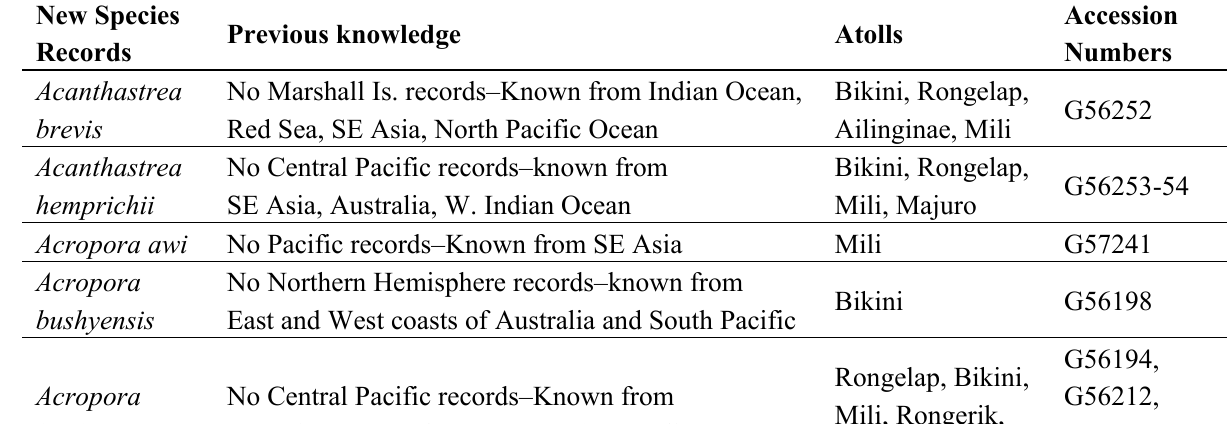
Table 1. Nineteen new scleractinian coral records from the Marshall Islands based on skeletal voucher specimens (and photos) collected from 2002–2010. Known distribution records based upon